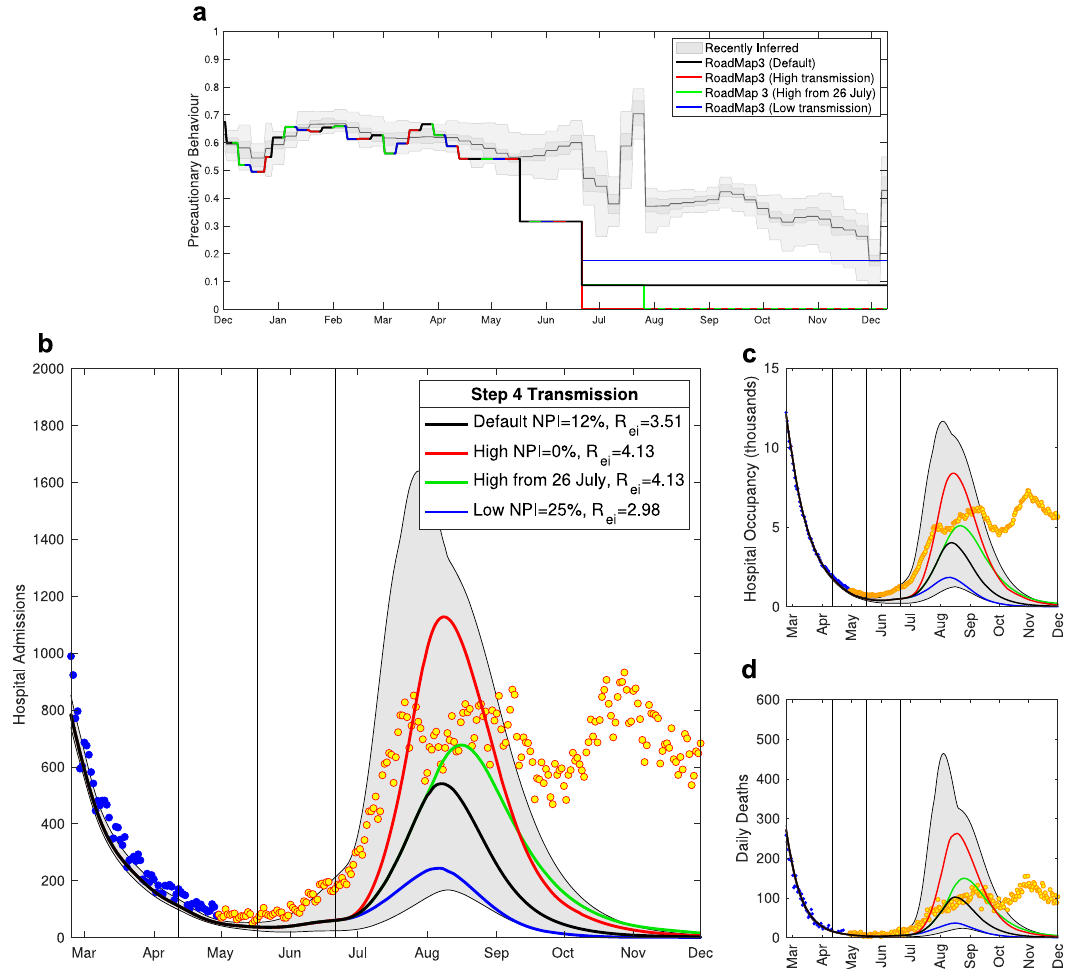
Fig. 5 | Severe disease projections from Roadmap 3 Figure 10 15 , which con- sidered the impact of social mixing and hence transmission in Step 4. a The most recently inferred level of precautionary behaviour (grey, showing mean, 50% and95%credibleintervals)togetherwiththeassumeddefaultlevelsfromRoadmap 3 15 . Lower panels show projected level of daily hospital admissions b , hospital occupancy c and daily deaths d together with the associated data until December